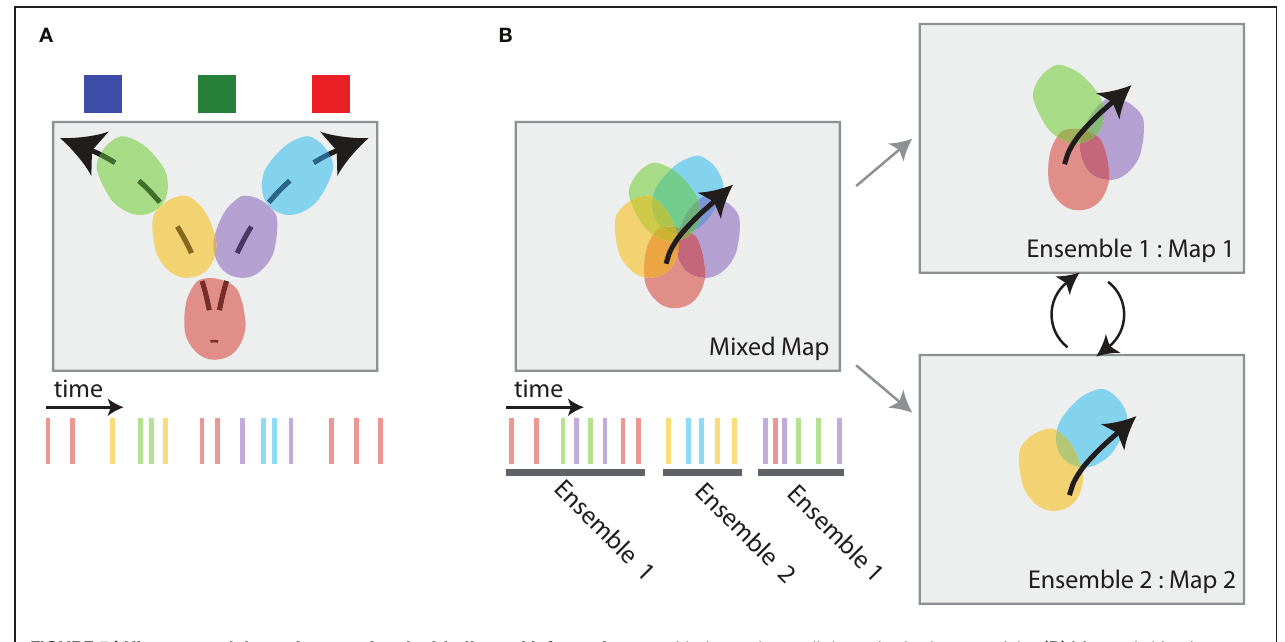
FIGURE 5 | Hippocampal dynamics associated with directed information foraging. (A) VTE-like dynamics in the hippocampus are non-local representations that occur at choice points. While the animal pauses at the choice point (the bottom-center of the box), spatial representations in the hippocampus move ahead of the animal, following potential trajectories toward the different reward source locations. The spiking activity associated